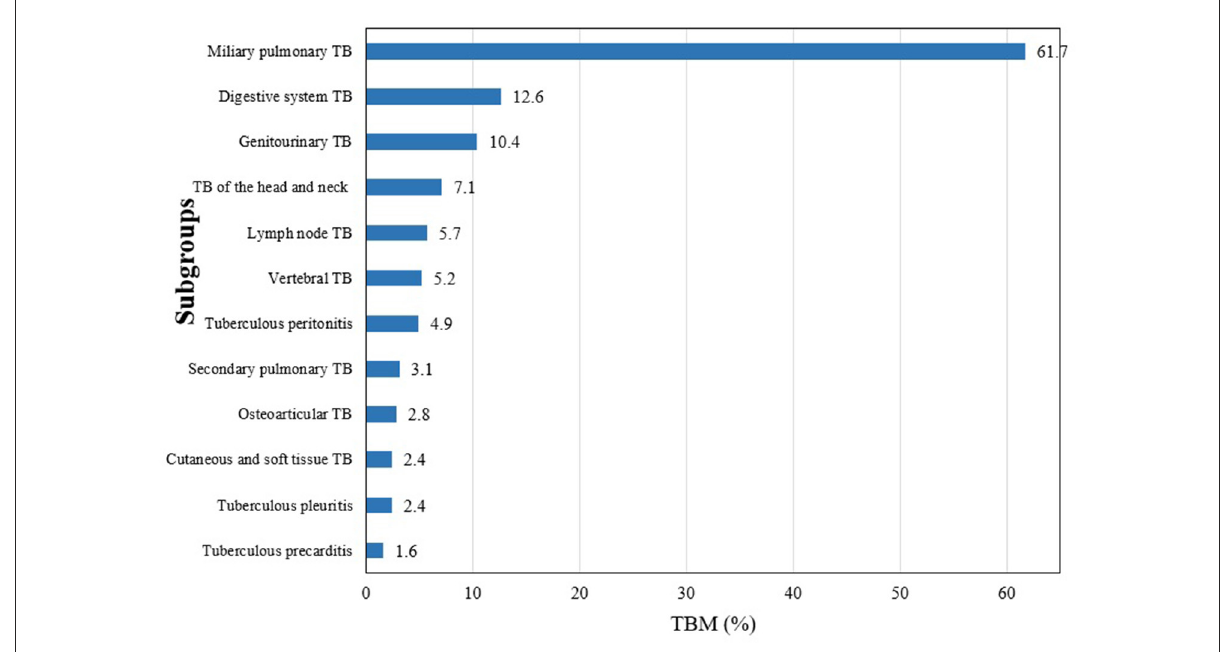
FIGURE3 The proportion of TBM in different types of